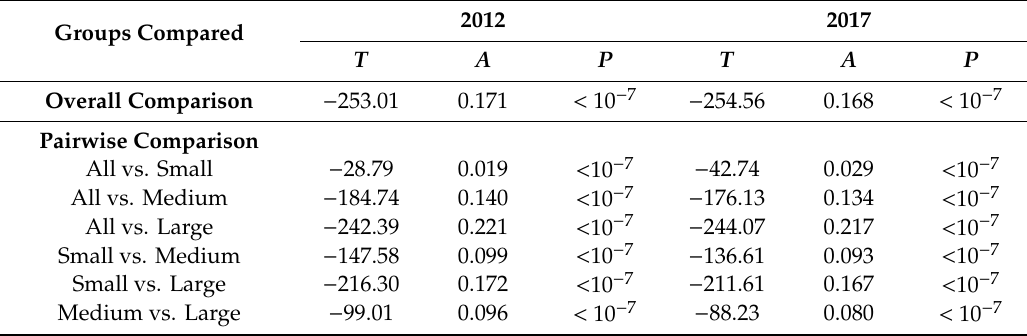
Table 4. Multi-response permutation procedures (MRPP) to test for significance of variation in di ff erent years plant species composition across di ff erent DBH classes. The DBH classes are as follows: All,